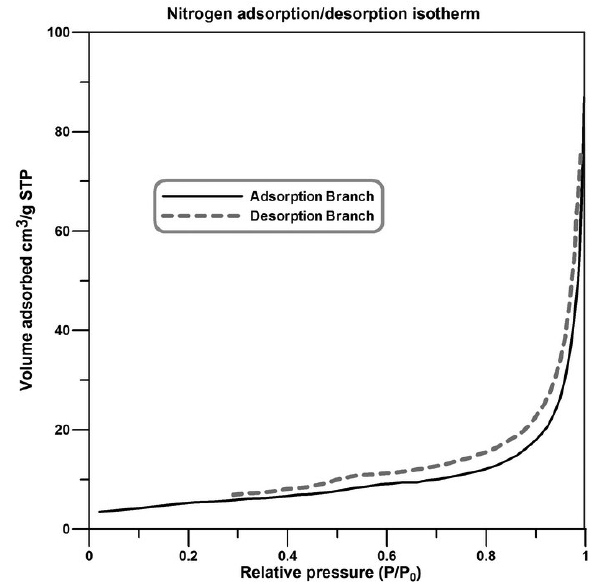
Figure 2: Nitrogen adsorption/desorption isotherm of the pristine diatomite sample